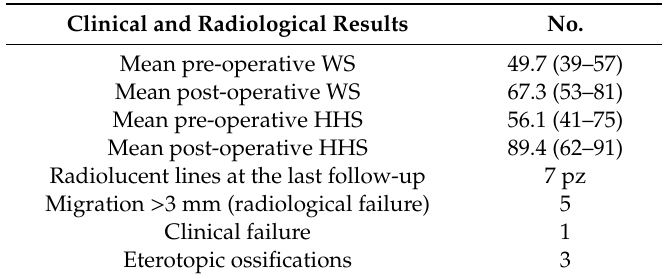
Table 2. Clinical and radiological results at the mean follow-up (4.4 years).